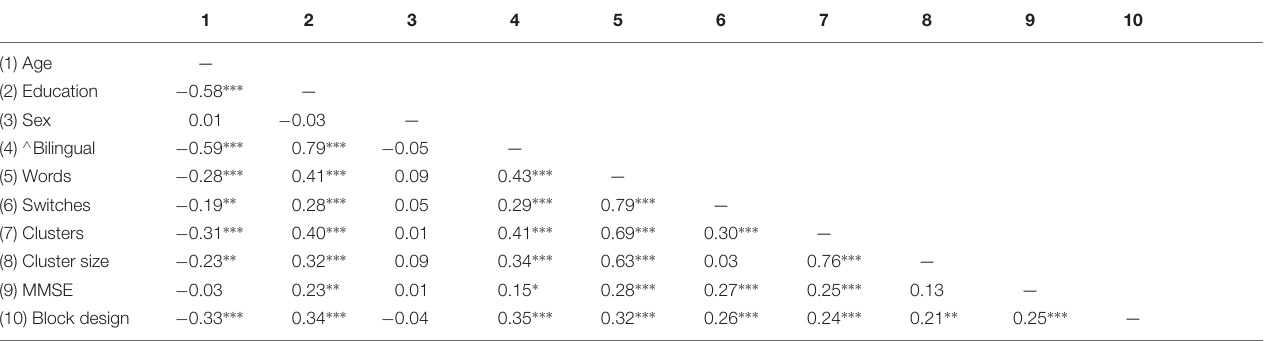
TABLE 3 | Person’s (point-biserial when dichotomous variabels) correlation between variabels at baseline.